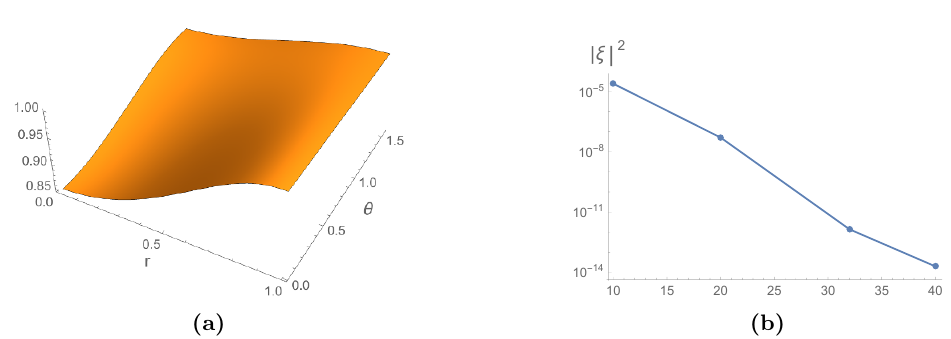
Figure 8. (a) Examples of numerical solutions for the metric function A of a large polarised black hole for an electric (cid:12)eld points.(b) Plot of convergence for the polarised black hole for a value of the electric (cid:12)eld temperature T = 1 =(cid:25)